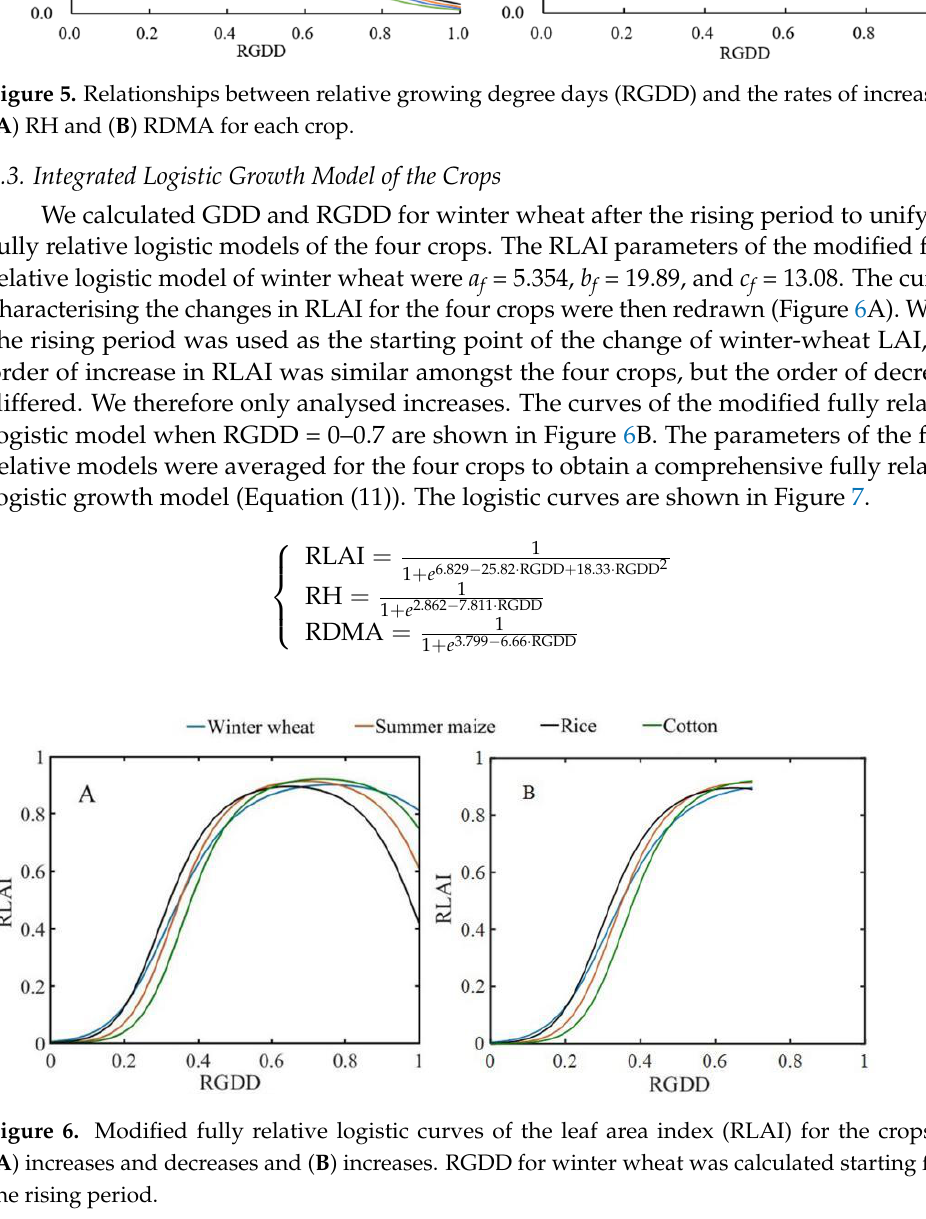
Figure 7. Comprehensive and fully relative logistic curves of the indices of growth for the four crops between ( A ) RLAI and RGDD, ( B ) RH and RGDD, and ( C ) RDMA and RGDD. Five sets of unmodelled data for each crop were used to evaluate Equation (11). Scat- ter plots between the measured and fitted values are shown in Figure 8. This comprehen- sive fully relative logistic model fitted the indicators well ( R 2 > 0.75, RMSE < 0.15, RE < 5%) except for RLAI for summer maize and cotton (Figure 8D,J). Equation (11) can therefore describe the growth of the crops well.